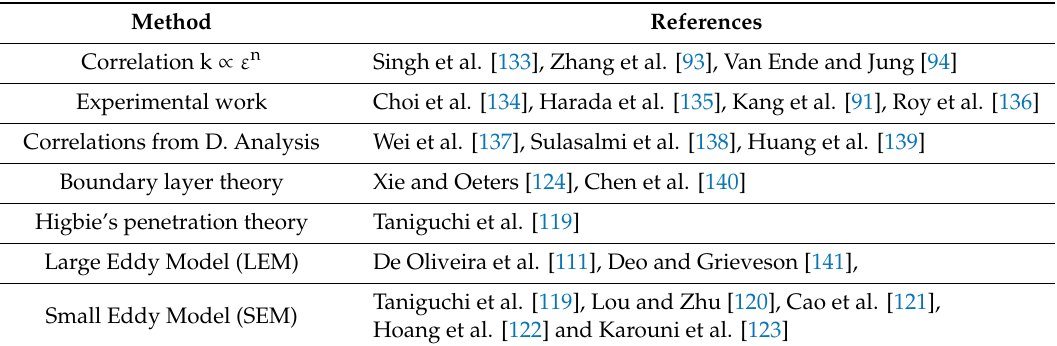
Table 4. Methods employed to compute k in reported kinetic